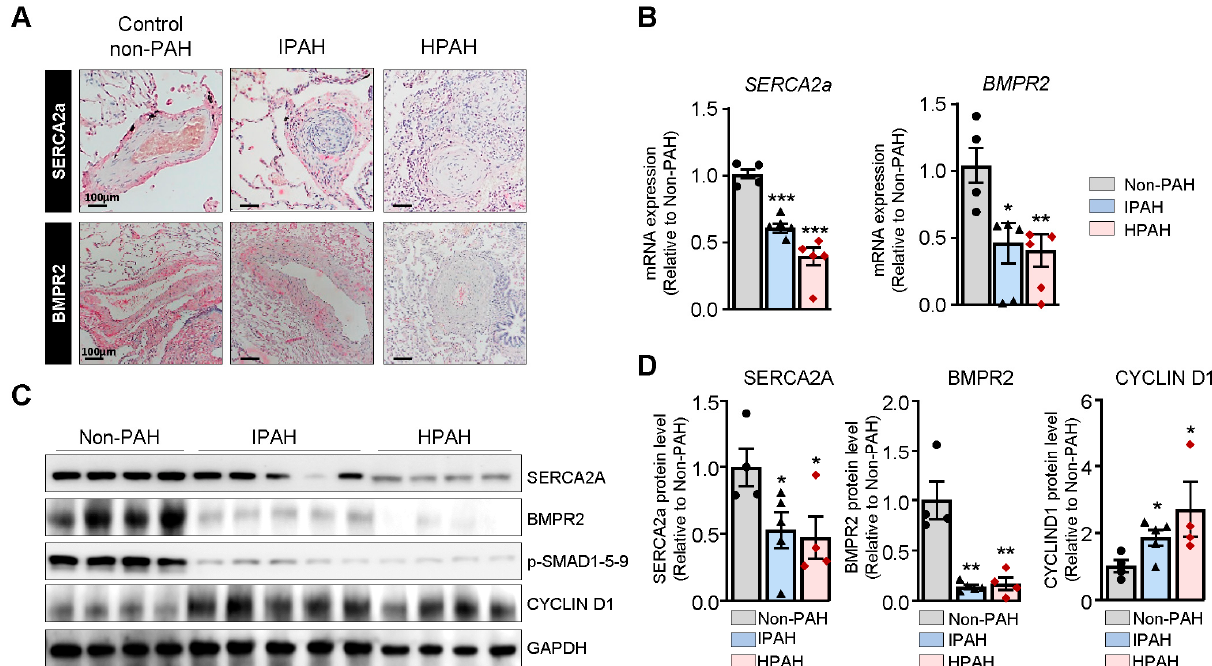
Figure 1. Expression of SERCA2a and BMPR2 in pulmonary vessels from non-PAH, idiopathic, and hereditary PAH patients. ( A ). Representative images of SERCA2a (upper panel) and BMPR2 (lower panel) expression assessed by immunohistochemistry using secondary antibodies conjugated with horseradish peroxidase in lung sections from idiopathic PAH (IPAH, Patient #5 in Supplementary Table S1), hereditary PAH (HPAH, Patient #1 in Supplementary Table S2) patients, and control non-PAH (non-PAH, Patient #1 in Supplementary Table S3). Scale bar: 100 μ m. ( B ). SERCA2a and BMPR2 mRNA expression was analyzed by RT-qPCR in lung tissue from control non-PAH (n= 4), IPAH (n = 5), and HPAH (n = 5) patients. ( C ). Representative immunoblots of SERCA2a, BMPR2, Cyclin D1, and phospho-SMAD1-5-9 (p-SMAD1-5-9) assessed through Western blot in lung tissue from control non-PAH (n = 4), IPAH (n = 5), and HPAH (n = 4) patients. GAPDH was used as a loading control. ( D ). Quantification of the indicated proteins normalized to GAPDH. Data are presented as mean ± SEM; * p < 0.05, ** p < 0.01, *** p < 0.001.